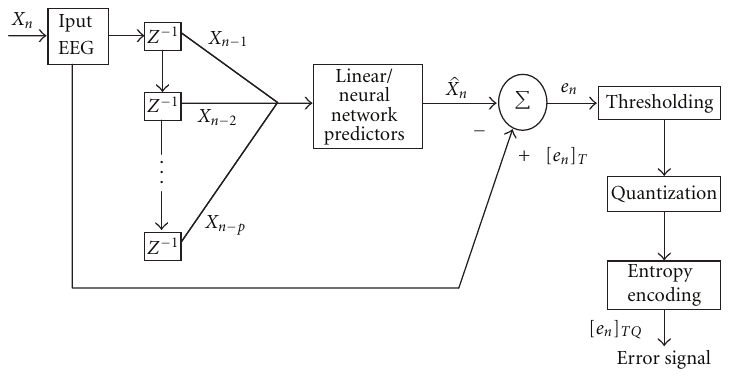
Figure 1: Quality on demand compression scheme.